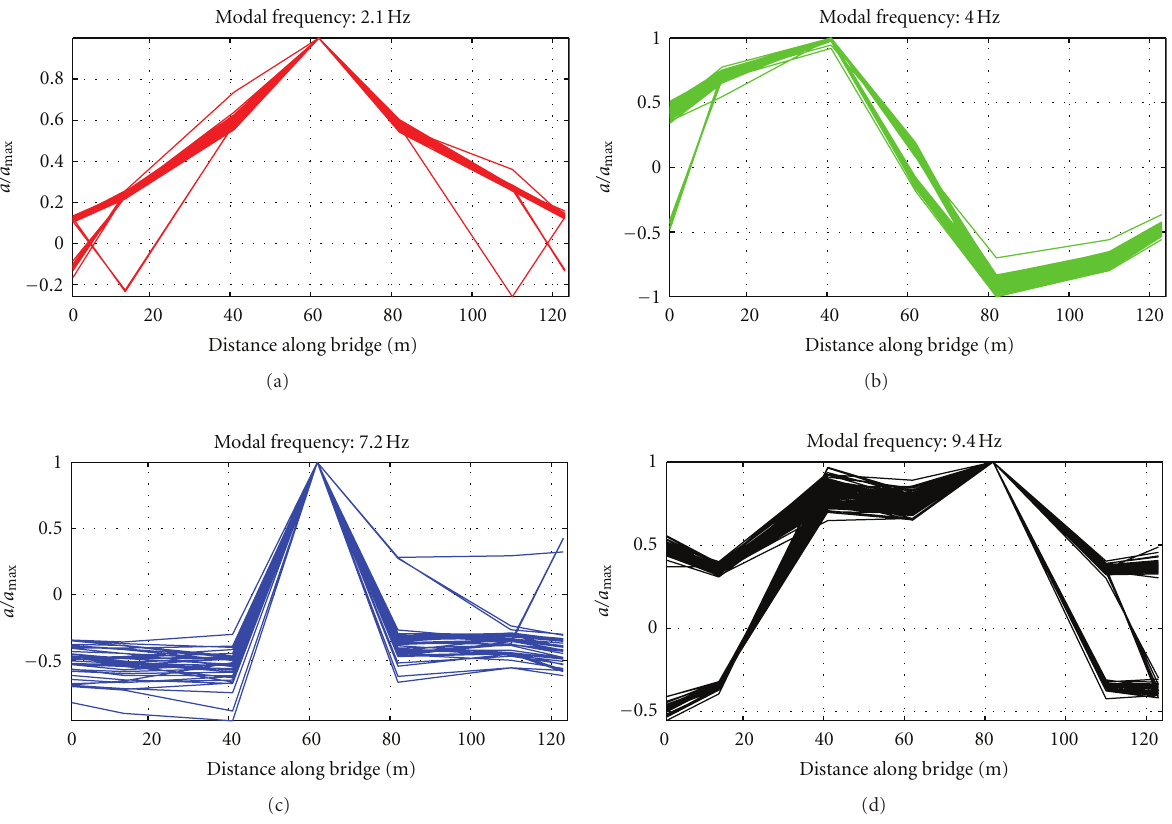
Figure 7: Example of the derivation of the modal shapes (transverse component, left side of deck) of vibration for the fundamental mode of resonance (upper left, red) and the three higher modal frequencies presented in Figure 6(b) and listed in Table 1. For each modal frequency, each individual line represents the modal shape derived from a one-minute time window. More details on the derivation are given in the